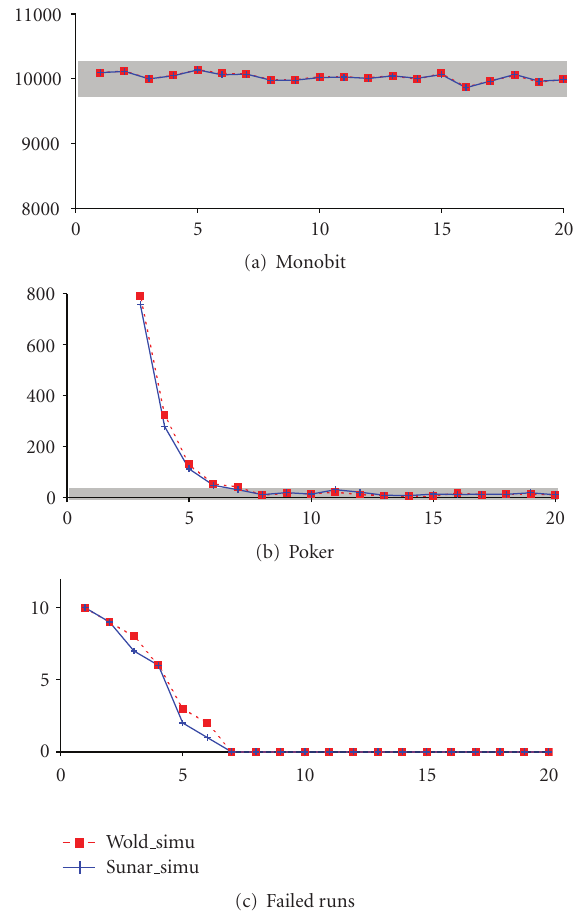
Figure 4: Results of the FIPS 140-2 tests in simulation with 30 ps of Gaussian jitter for Sunar’s and Wold’s architecture (excluding long runs that always passed), the tests pass if the results are in the gray region or are equal to zero for the “Runs”